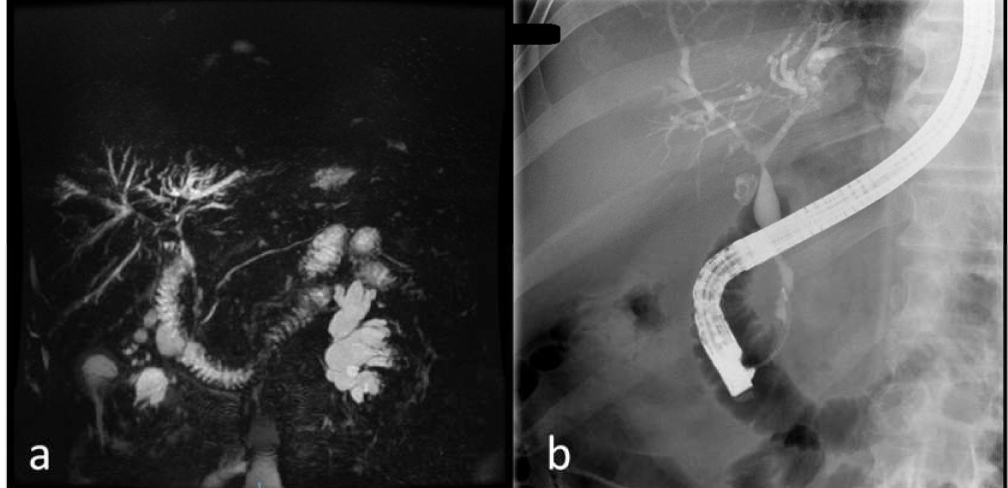
Figure 2. Cholangiography of a patient with PSC from our clinical practice: ( a ) magnetic resonance cholangiography (MRCP) images; ( b ) endoscopic retrograde cholangiopancreatography (ERCP)